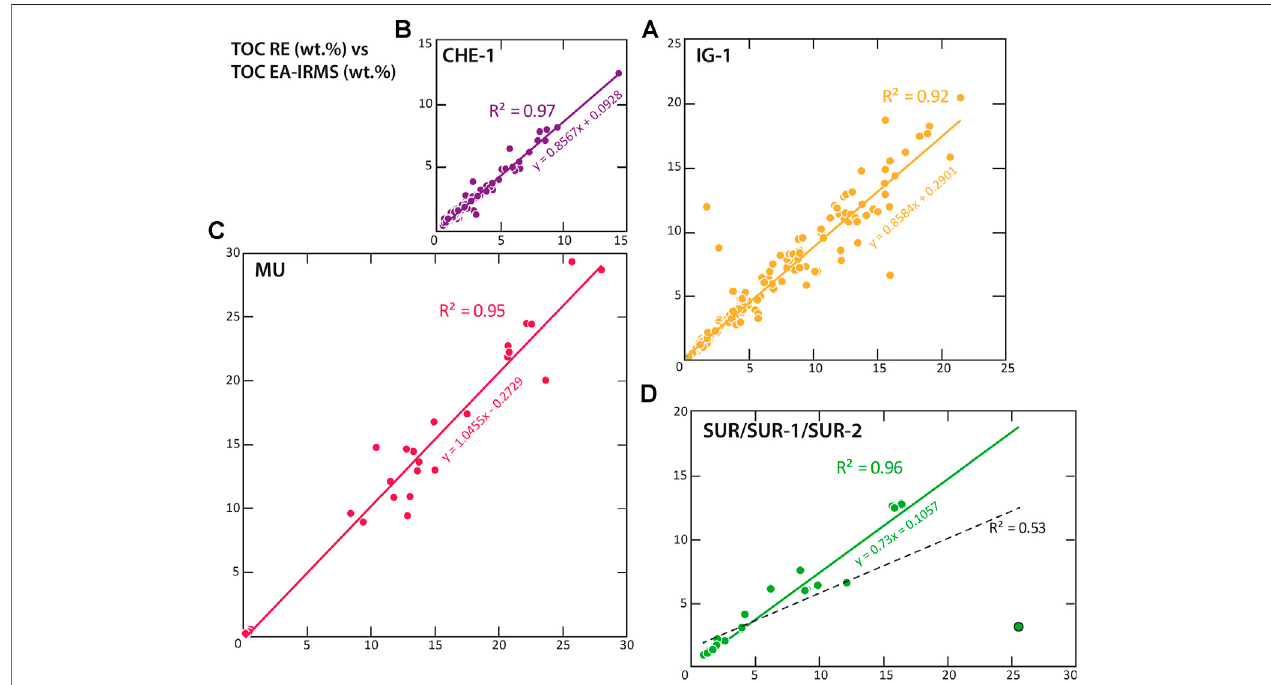
FIGURE8 | Total Organic Carbon (TOC) valuesobtained by Rock-Eval pyrolysis (RE, ordinate)vs TOCvalues obtained byelemental analyzer (EA-IRMS, abscissa) showing a proportionality between the two measurements. (A) IG-1 well, R 2 (cid:2) 0.92. (B) CHE-1 well, R 2 (cid:2) 0.97. (C) MU well, R 2 (cid:2) 0.95. (D) SUR section and SUR-1 and SUR-2 well for which two regression lines are calculated: one comprising all the points ( R 2 (cid:2) 0.53) and a second without the outlier (point with black circle, R 2 (cid:2) 0.96), showing that there is probably a measurement error with this point given the difference higher than 20% between the two methods.